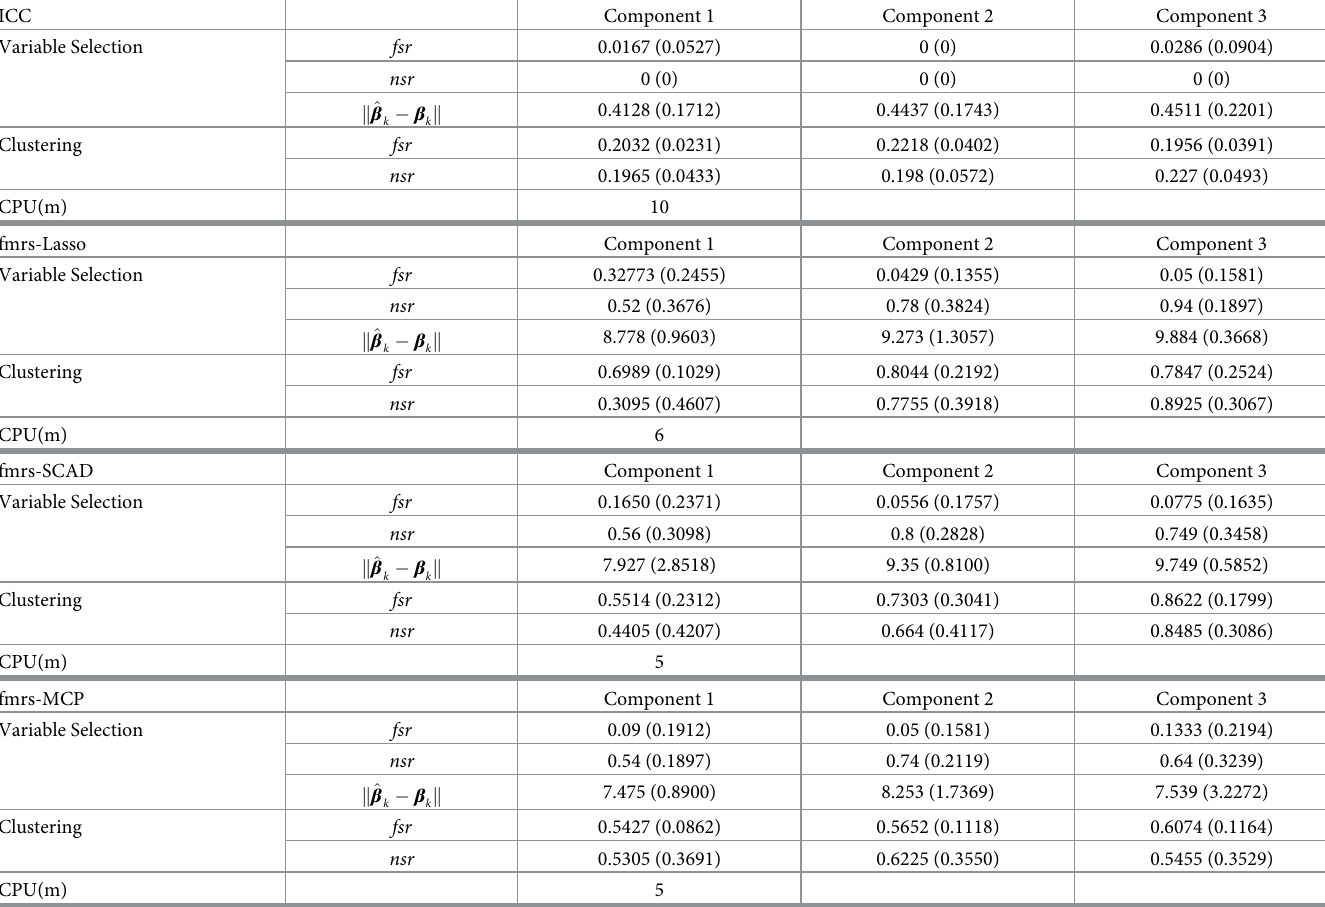
Table 3. Comparison of the ICC and regularization methods, where fsr, nsr and k ^ β dard deviation given in the parenthesis. The regularization methods were implemented with the Lasso, SCAD and MCP